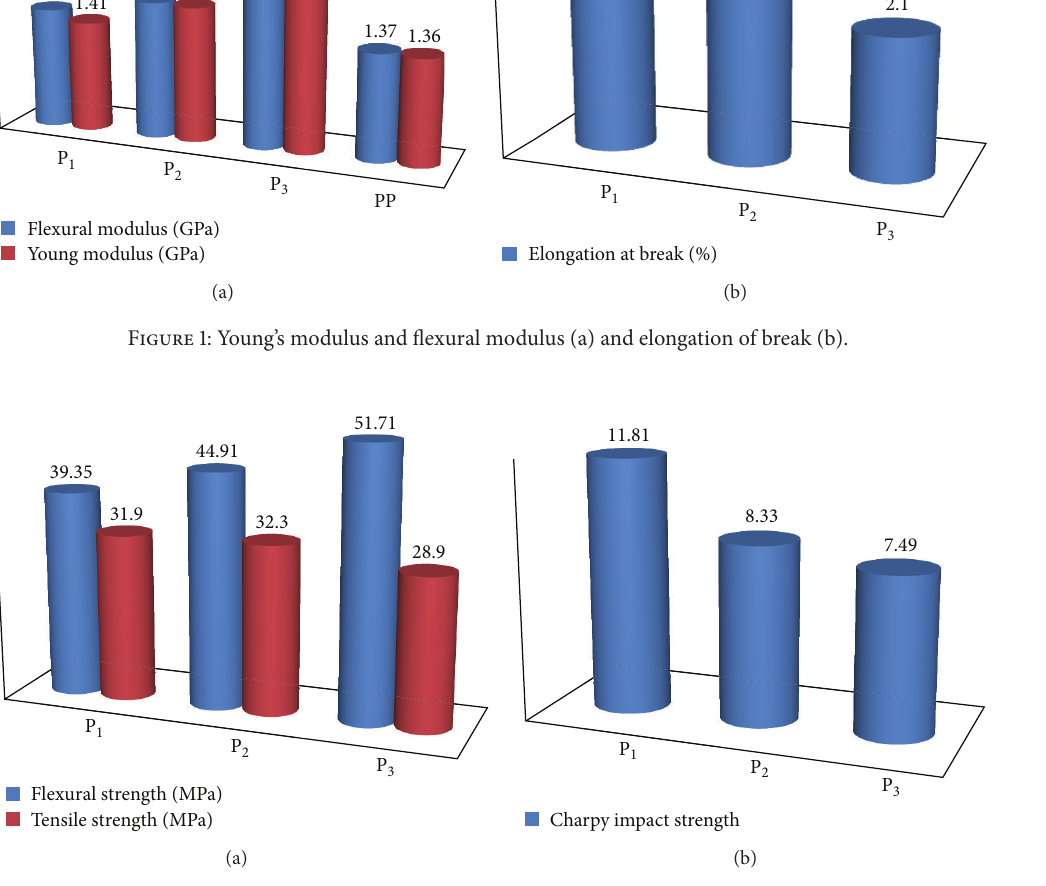
Figure 2: Tensile strength and flexural strength (a) and Charpy impact strength